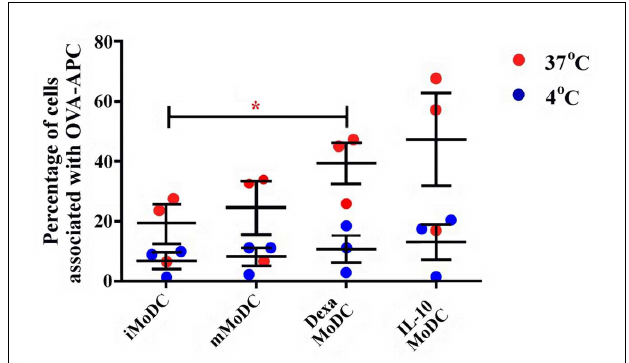
FIGURE 9 | qPCR detection of PRRSV replication in MoDC subsets at 16, 24, 48, and 72 h post infection. Immature/iMoDC (black), maturation cocktail treated mature/mMoDC (dark blue), dexa treated MoDC (light blue), and IL-10 treated MoDC (orange), were infected with PRRSV Lena using an m.o.i of 0.1. Viral RNA was extracted from cells at either 16, 24, 48, or 72 h p.i and a TaqMan qPCR with an 18S endogenous control was used to obtain C t values. (cid:49)(cid:49) C t represents difference between C t at 2 h p.i (time zero) and C t at each time point p.i, both normalized to 18S. Bars represent mean (cid:49)(cid:49) C t ± SD.